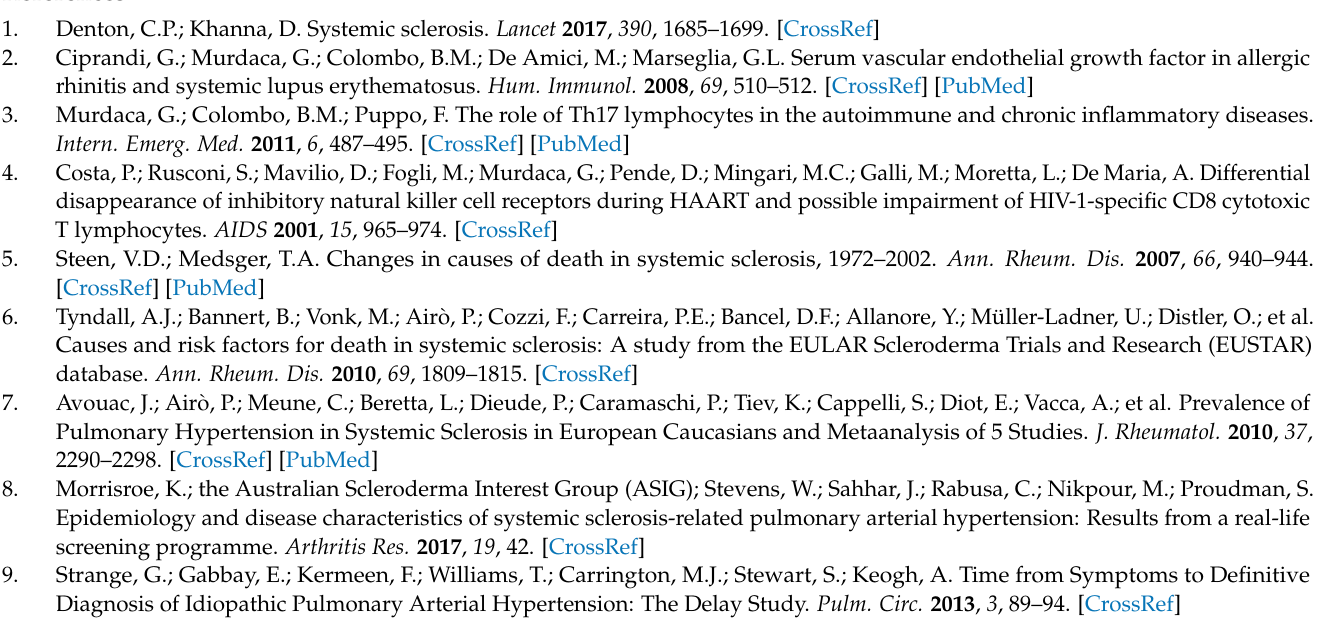
Table S1: 3-year follow-up of the 9 patients without pulmonary arterial hypertension at right heart catheterization at